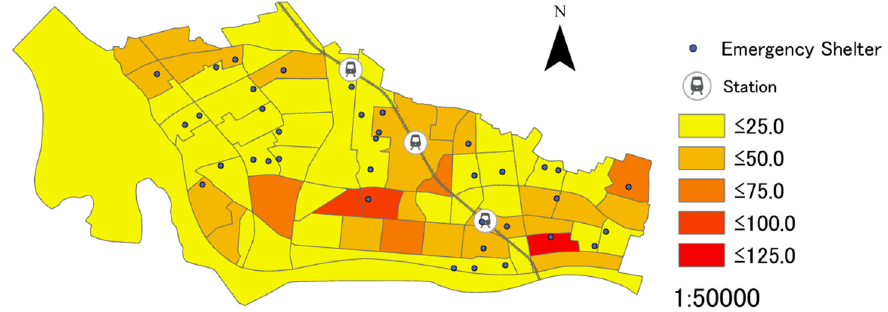
Figure 15. Result for Toda City with the specialization coefficient of population density as a weighted coefficient.